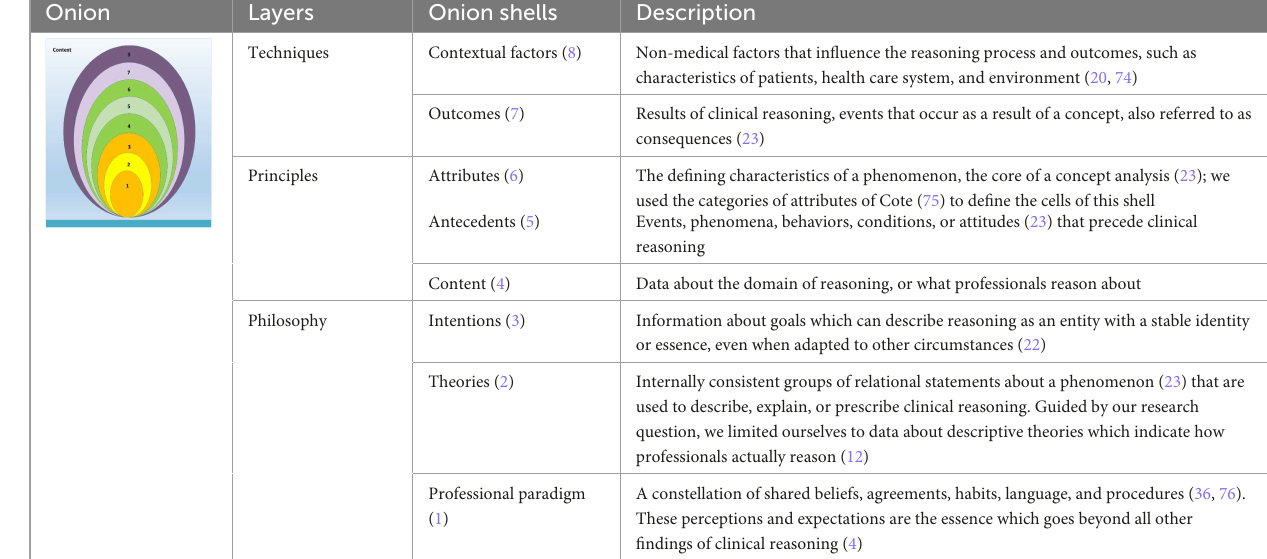
TABLE 2 Layers and shells of clinical reasoning.